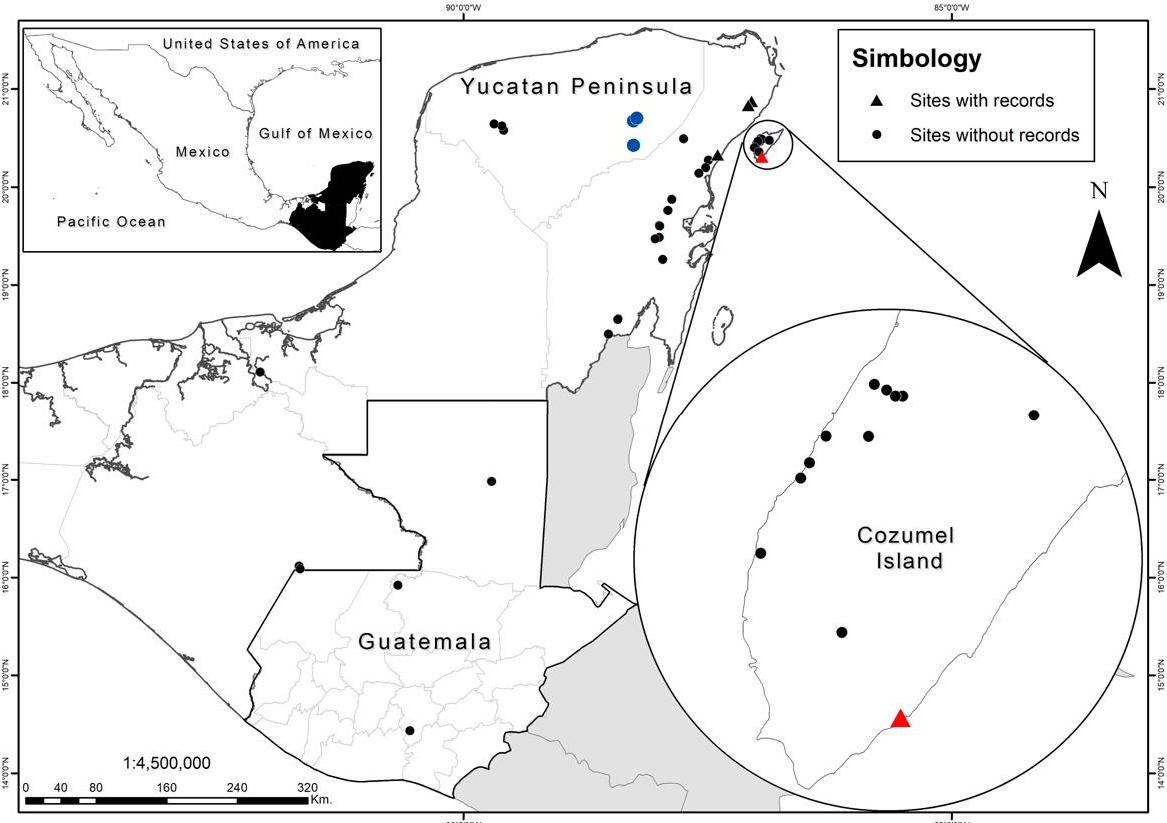
Figure 1. Collection sites for zooplankton samples in the YP, Mexico (2005–2020), where diaptomids are present. Black Figure 1 circles are negative records of Mastigodiaptomus ha ; triangles are positive sites for records of M. ha . The red triangle is the place where the species was founded on Cozumel Island. Blue circles indicate probable presence of this